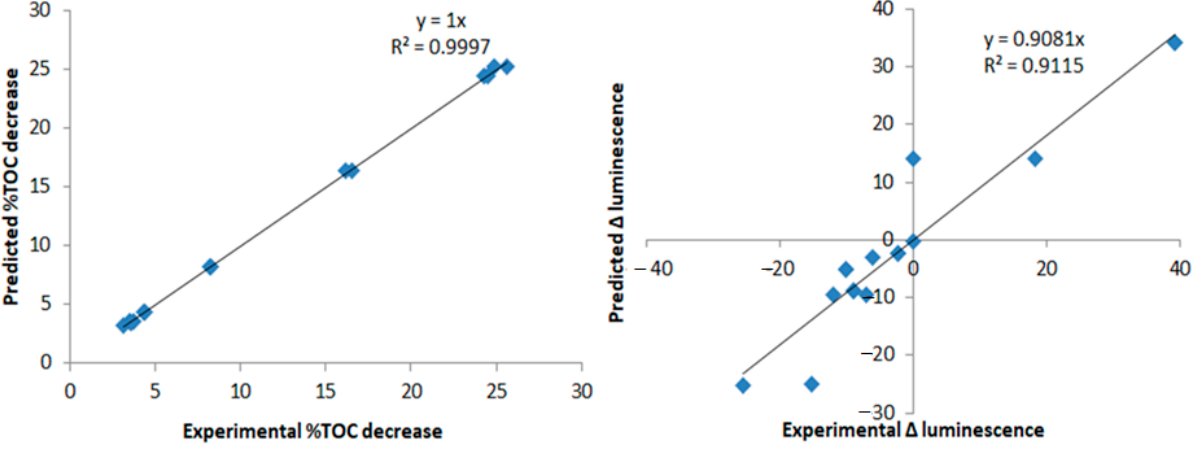
Figure 5. Model predictions vs. experimental %TOC decrease and ∆ luminescence for the categori- cal